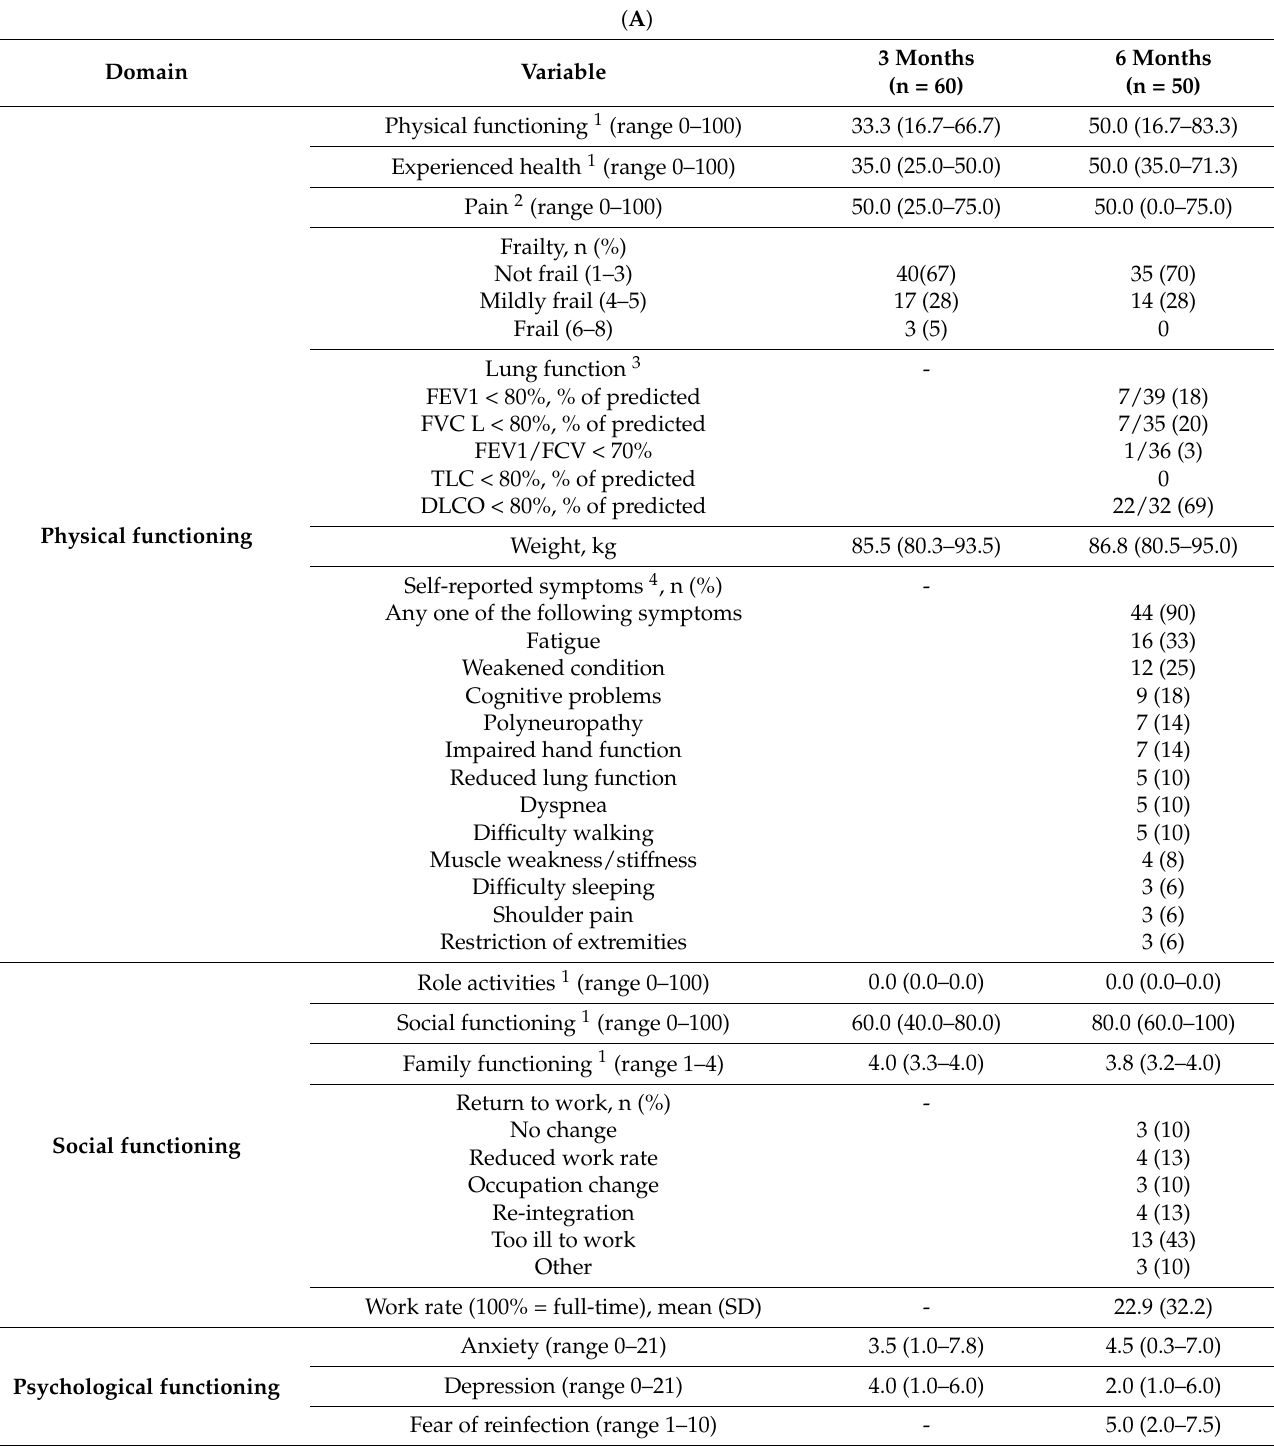
(Table 2B). Fear of reinfection had a score of 5.0 for ICU-survivors and 6.0 for family members at six months. Table 2. The physical, social, and psychological functioning of COVID-19 ICU survivors and their family members 3- and 6-months post